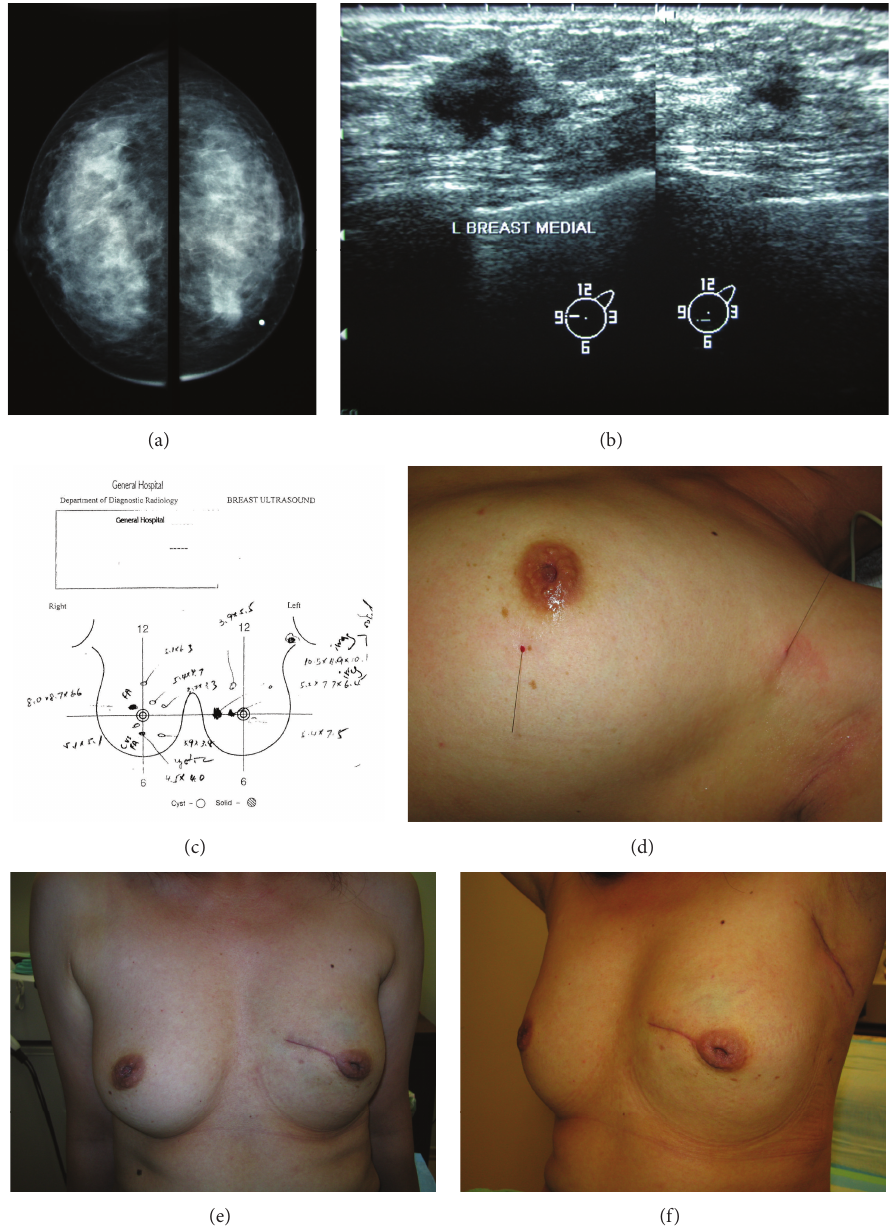
Figure 1: ((a)–(f)) Avoiding mastectomy in a patient with “multifocal tumour” on imaging. This 45-year-old patient was diagnosed with what was thought to be multifocal invasive ductal carcinoma at another facility following core biopsy. Mastectomy was originally recommended at the first centre due to the presence of multiple synchronous ipsilateral tumours and proximity of one lesion to the nipple. She sought a second opinion at the authors’ facility and was agreeable to a “trial of breast conservation treatment.” Localisation of the impalpable periareolar lesion and of the suspicious axillary lymph node was performed. She underwent an en bloc wide excision of the two left breast lesions through a boomerang incision and axillary staging through a separate axillary incision. The sentinel node coincided with the localised node and was found to be positive for metastasis on frozen section analysis. She underwent axillary dissection at the same operation. Histology was reported as a 4cm invasive ductal carcinoma, with no intervening normal tissue between the clinical lesions. Three of sixteen axillary lymph nodes were involved. She is currently disease-free after more than 5